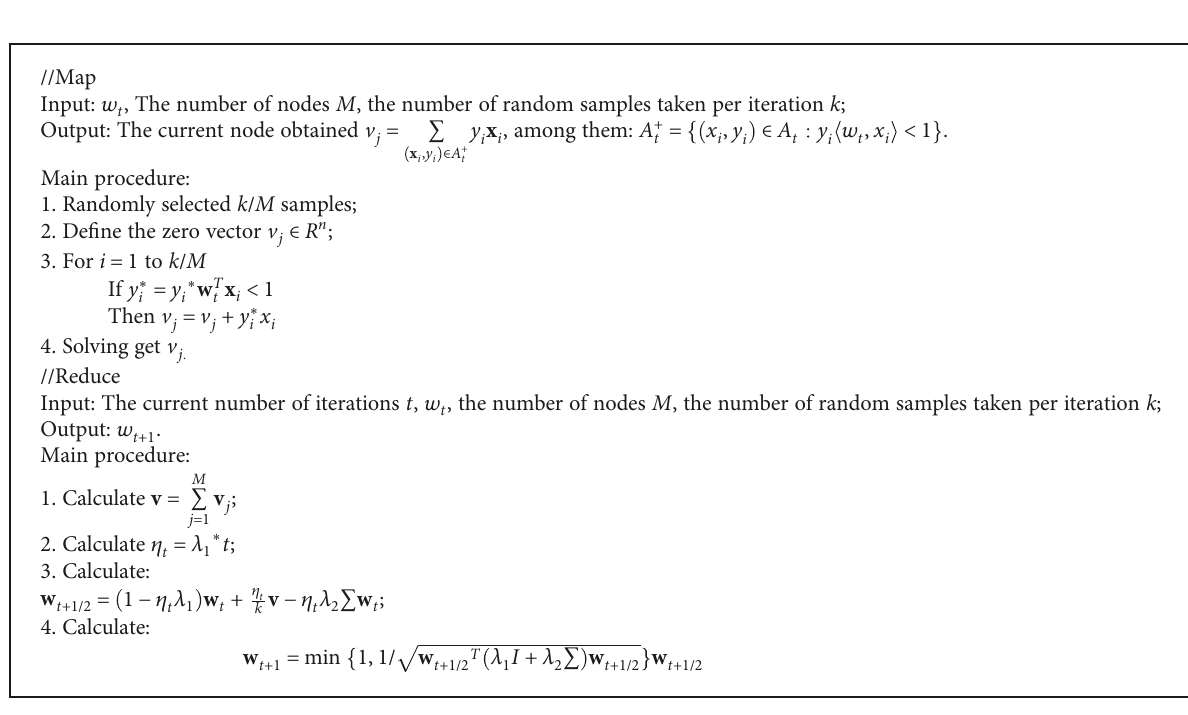
Algorithm 4: Parallel algorithm design of Pegasos ’ t th